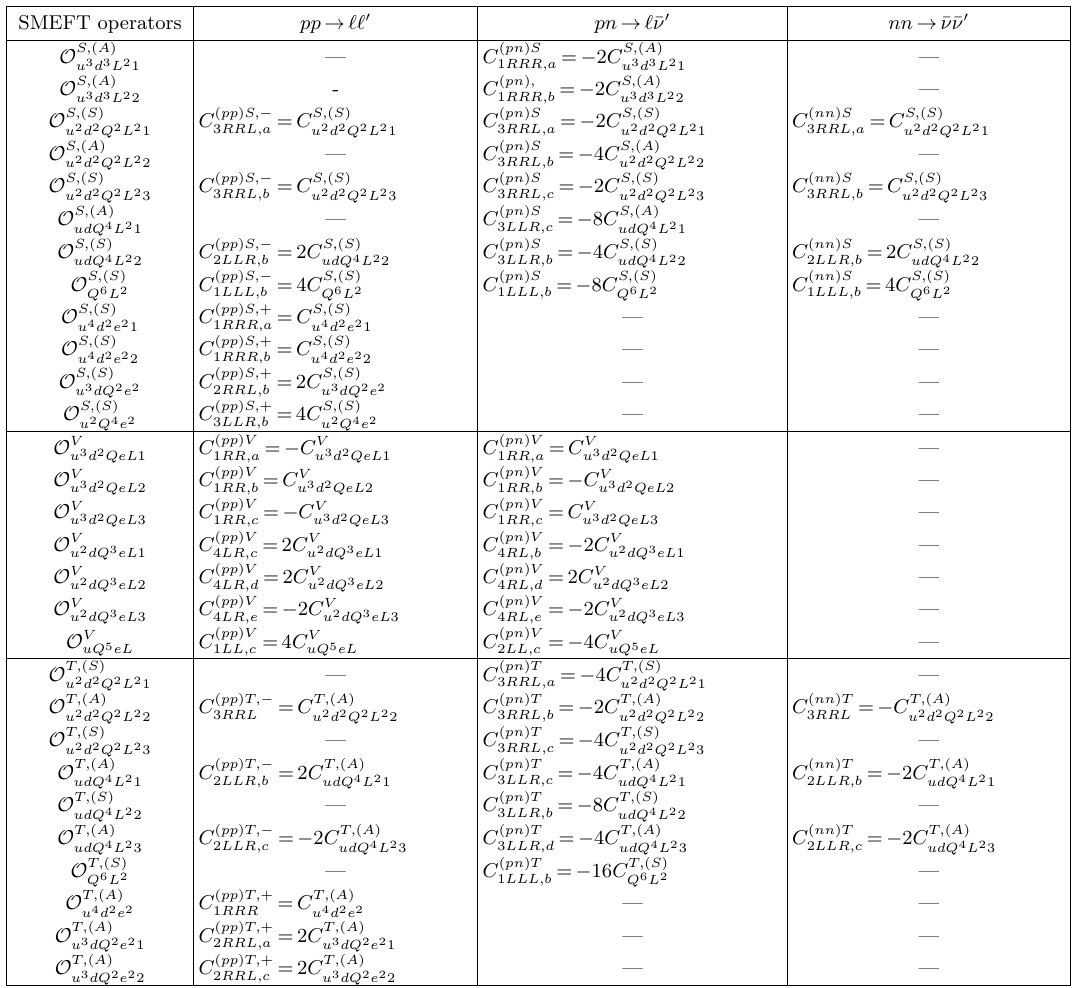
Table 2 . The SMEFT dinucleon to dilepton operators and their matching onto the LEFT at the Λ EW . Where the notation for the Wilson coefficients is similar to the corresponding operators with the replacement of O by C , e.g., C T, ( A ) for O T, ( A ) , We do not show the explicit flavors of u 3 dQ 2 e 2 2 u 3 dQ 2 e 2 2 leptons in the above matching but can be easily recognized through the corresponding